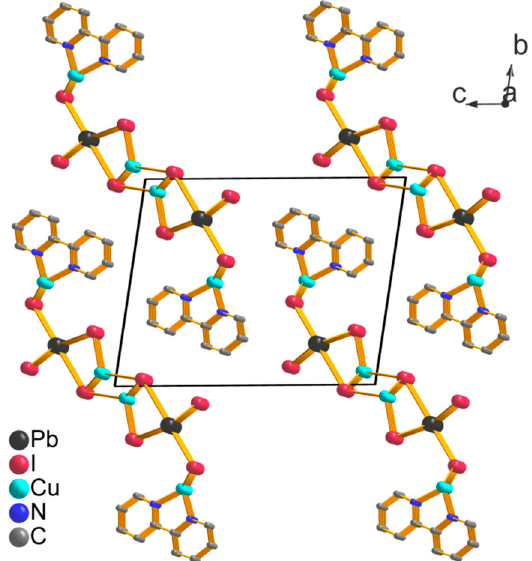
Figure 3. Packing diagram of 1 . All H atoms have been omitted for clarity.